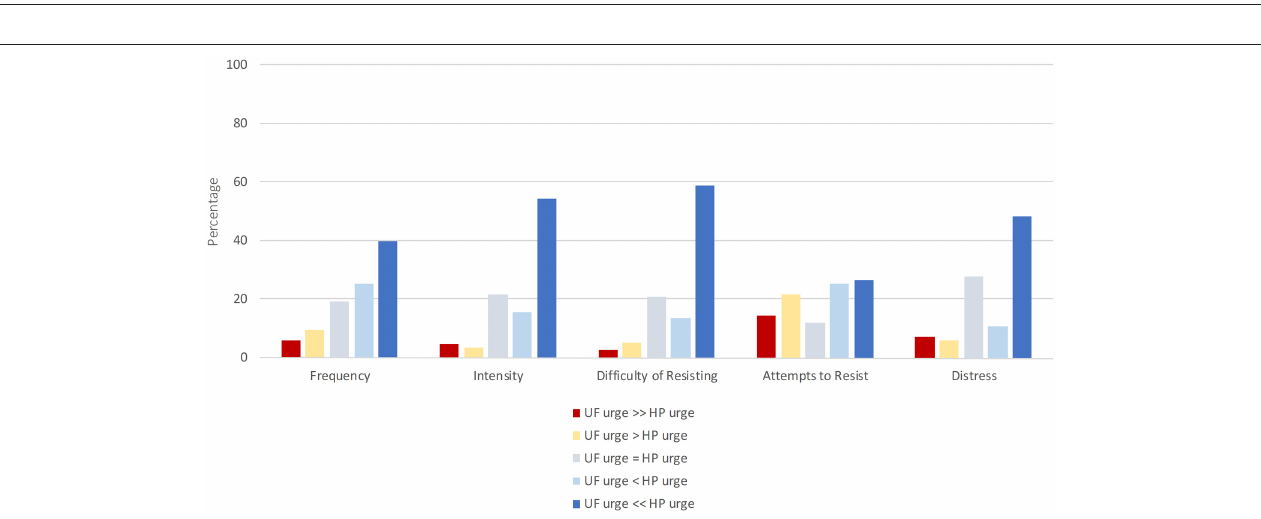
FIGURE 2 | Head to head comparisons of hair pulling and unhealthy food urges. UF + group: Histograms of responses to head-to-head questions asking participants to directly compare hair pulling and unhealthy food urges with respect to some property. For each urge property (frequency, intensity, difficulty of resisting, attempts to resist, and distress), participants indicated either that unhealthy food (UF) urges were equal in severity to hair pulling (HP) urges, or that one urge was “slightly” ( > ) more severe than the other, or that one urge was “much” more severe ( >> ) than the other.